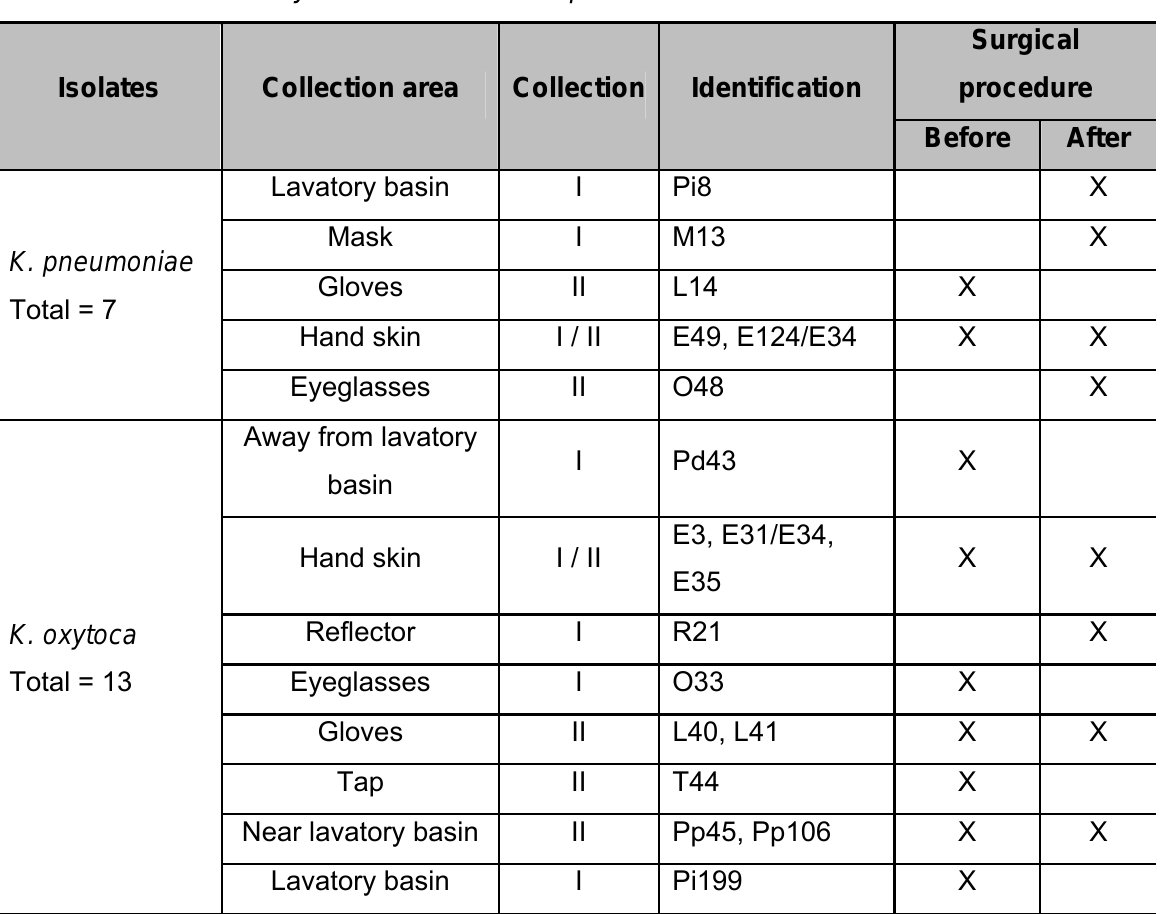
Table 1. Klebsiella oxytoca and Klebsiella pneumoniae